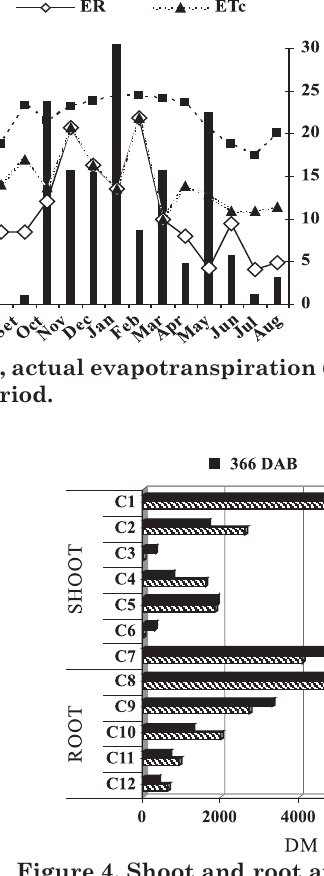
and C contain more than twice 13 14 to C . 15 17